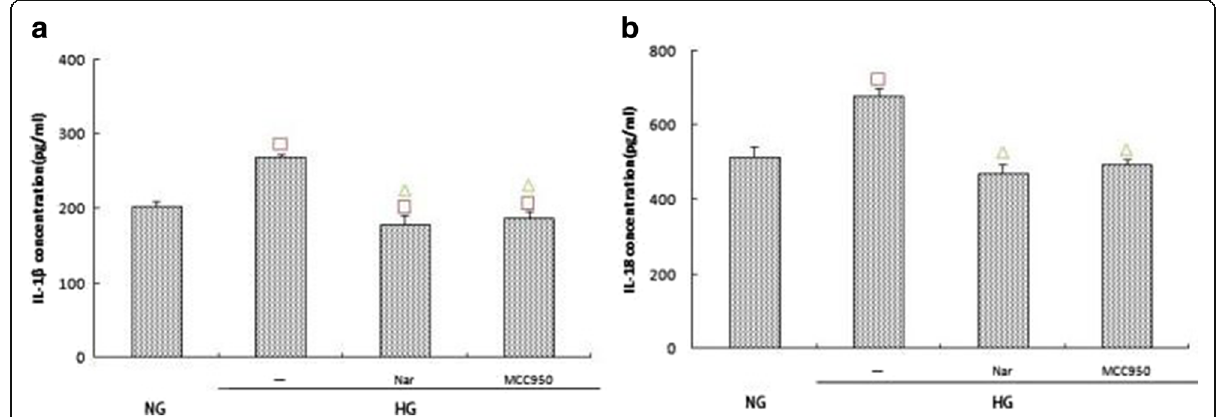
Fig. 11 a , b Effects of naringin (40umol/L) and MCC-950 (100umol/L) on the expression of IL-1 β and IL-18 within the high glucose group.The protein levels of IL-1 β and IL-18 in culture supernatants were determined by ELISA. NG:normal control group,HG:high glucose